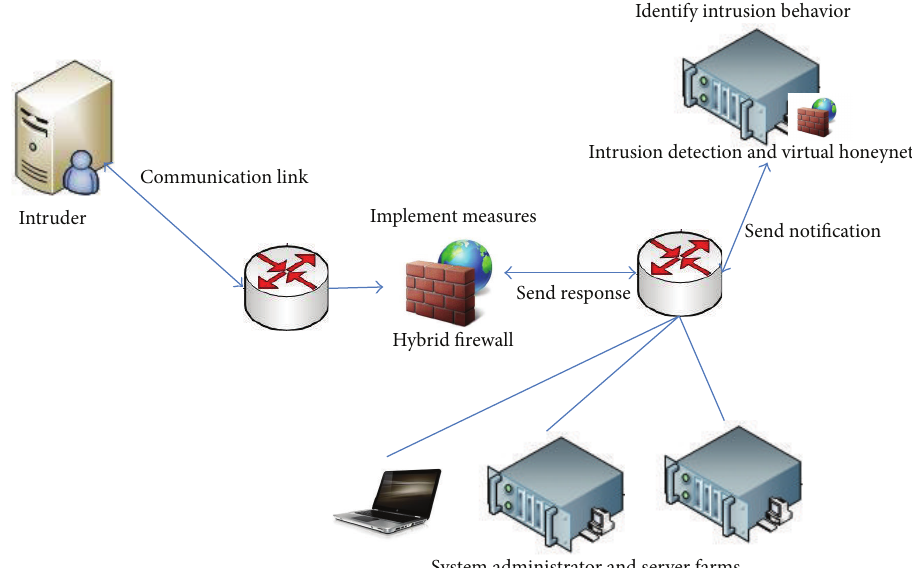
Figure 4: Schematic representation of a network